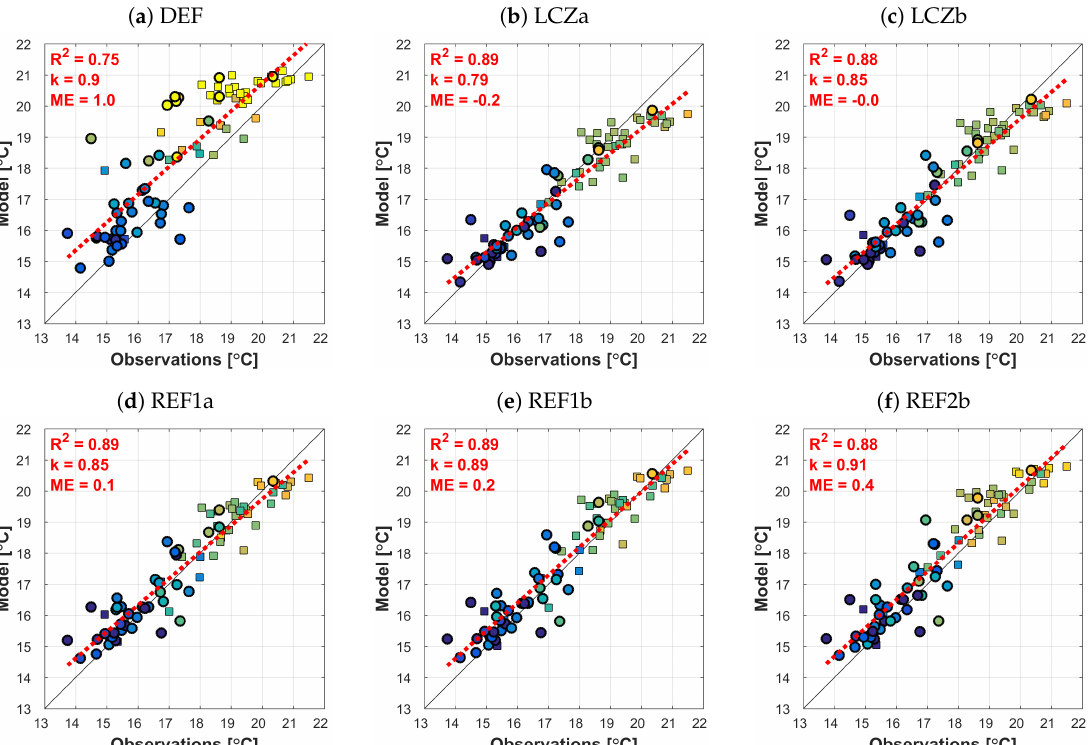
Figure 10. Comparison between the observed and modelled nocturnal (21, 00 UTC) temperatures, averaged over the selected sub-period in August 2017 for DEF ( a ), LCZa ( b ), LCZb ( c ), REF1a ( d ), REF1b ( e ), REF2b ( f ) model simulations. Circle and square markers represent the WSs and AAQSs respectively, the color of the marker represents the ISA for the corresponding grid cells (blue-to-yellow colormap ranging from 0 to 100 as in Figure 4). Red dotted lines indicate the linear trends, and skill scores in the top left corners indicate the trend determination coefficient R 2 , the slope coefficient k and the model mean error